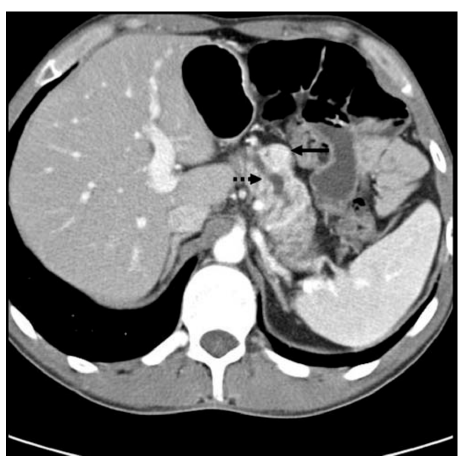
Figure 6. CT scan showing a PPoma of the head (solid arrow) of the pancreas causing pancreatic duct dilation (dashed arrow). The tumor is a discrete lesion, with well-defined borders, and shows contrast enhancement in the arterial phase [30].